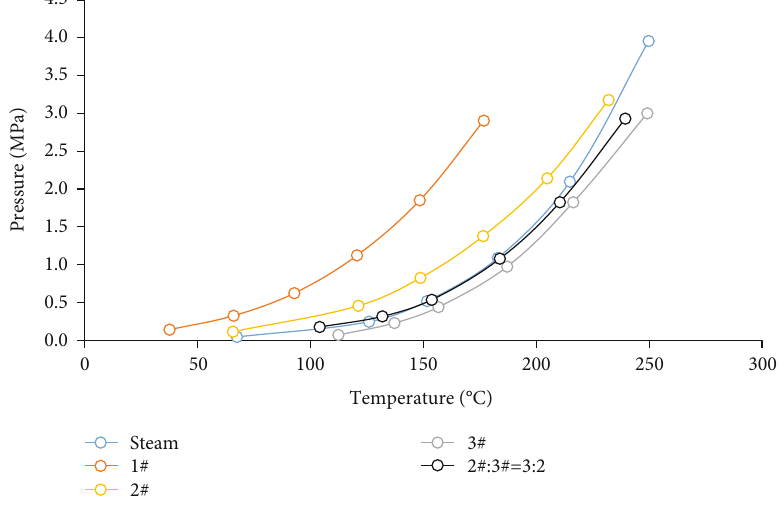
Figure 5: Vapor pressure curves of di ff erent solvent oil-water